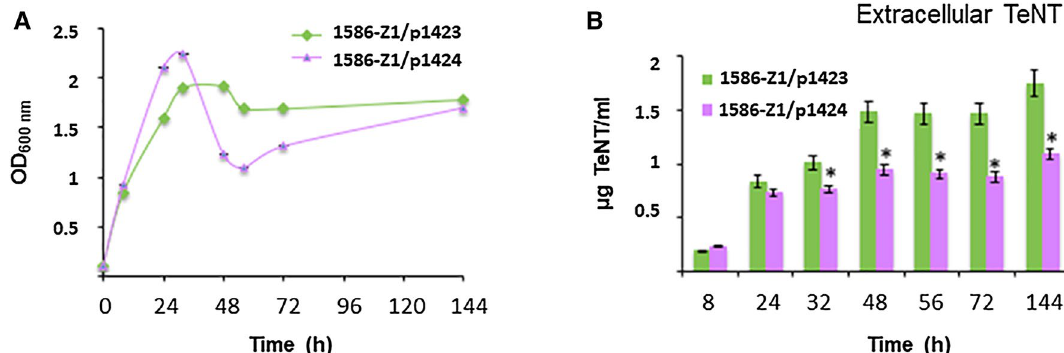
Figure 7. Growth and TeNT production in recombinant C. tetani strain 1586-Z1 (lacking the wild-type large tent plasmid), harboring the plasmid constructs p1423 ( tent locus with sRNA) and p1424 ( tent locus without sRNA). ( A ) Growth kinetics of C. tetani 1586-Z1/p1423 (containing tetR and tent genes with sRNA) and 1586- Z1/p1424 (containing tetR and tent genes without sRNA) in TGY medium. ( B ) Extracellular TeNT levels were higher in strain 1586-Z1/p1423 than in strain 1586-Z1/p1424. Statistical significance of differences between the two recombinant strains is indicated with p-values (* P < 0.05; ** P < 0.01). The data are from three independent